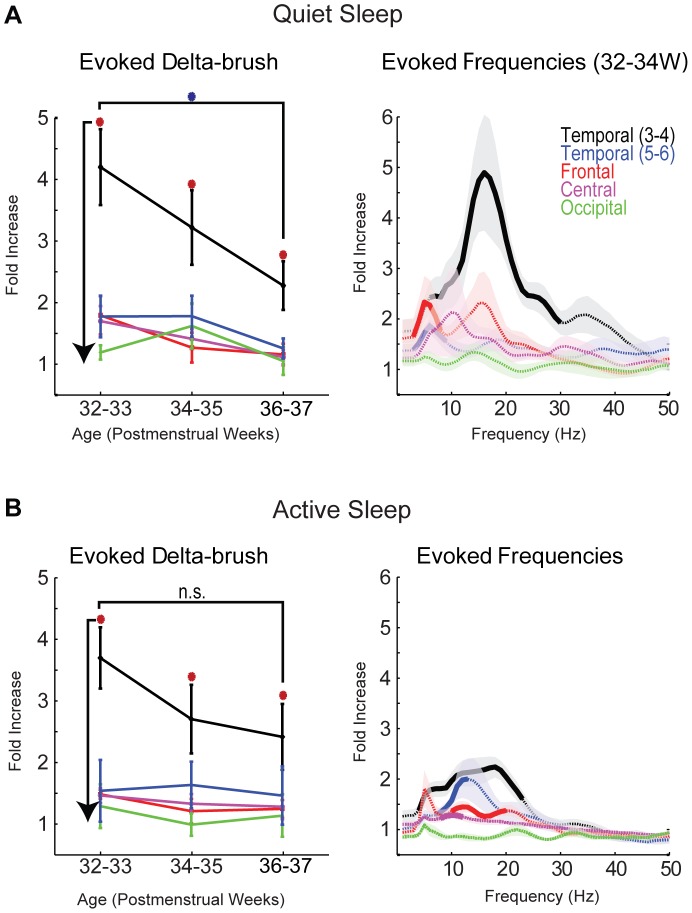
Age and sleep stage dependence of auditory evoked delta-brushes.
A–B: Left column: Increased delta-brush occurrence (expressed as a ratio of evoked to spontaneous brushes) for the 2 second period following “periodic” auditory stimulation (“click” or voice)/baseline rate. QS and AS are graphed separately. Left and right electrodes are pooled and each electrode pair is shown by different colors (error bar is SEM). Orange circles show significant elevation above baseline (p<0.05), while the blue asterisk shows significant difference between age groups. Right column: elevation of frequency power (1–50 Hz) for 32–34 postmenstrual weeks. QS and AS are graphed separately Colored line denotes mean elevation for each electrode, while SEM is indicated by shaded region. Solid bold lines show the frequencies significantly elevated above baseline (p<0.05); dotted lines show non-significant frequencies.